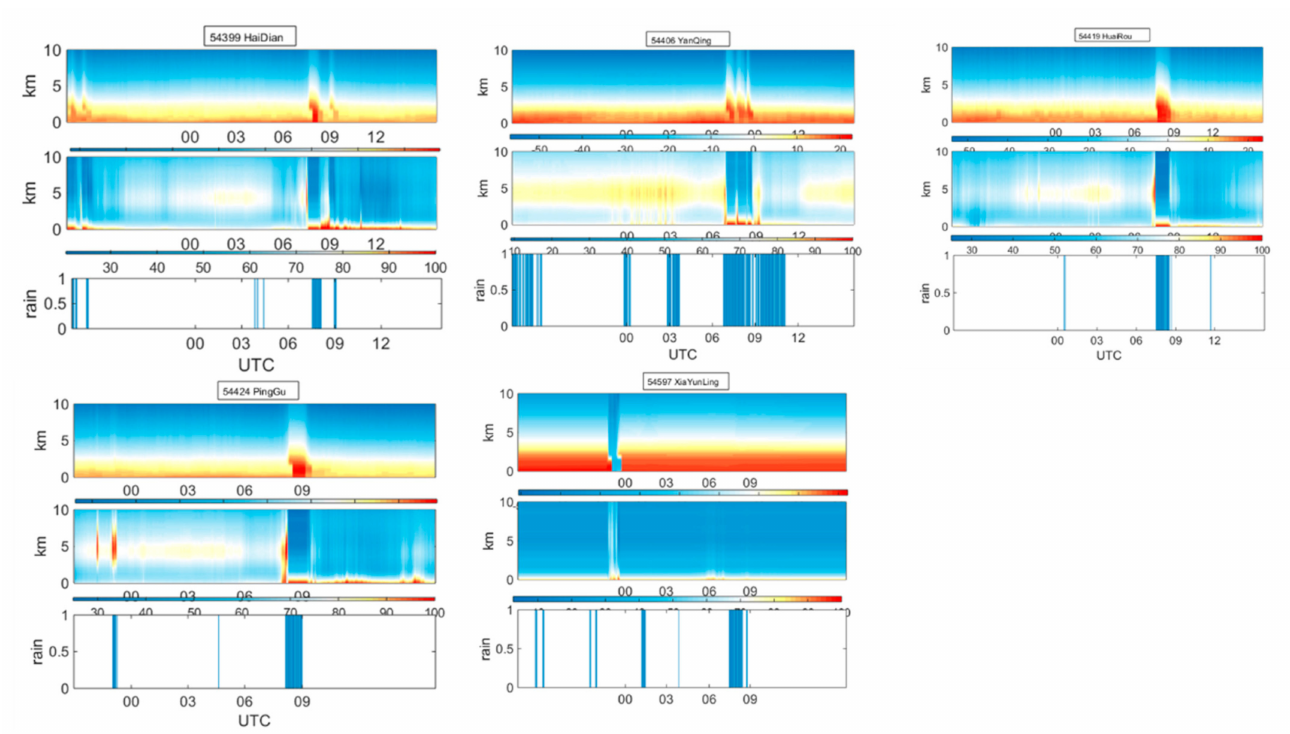
Figure 3. Time series of temperature and humidity profiles retrieved from five ground-based mi- crowave radiometers and the prediction of rain at corresponding times on 21 May 2020. The blue bar indicates the time of precipitation in the MWRPS observations. Altitudes are given in kilometers above ground